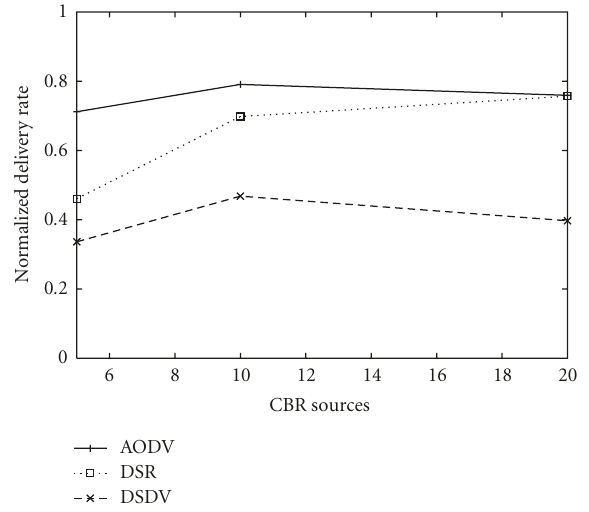
Figure 13: Delivery rate of protocols using the GIMM model.